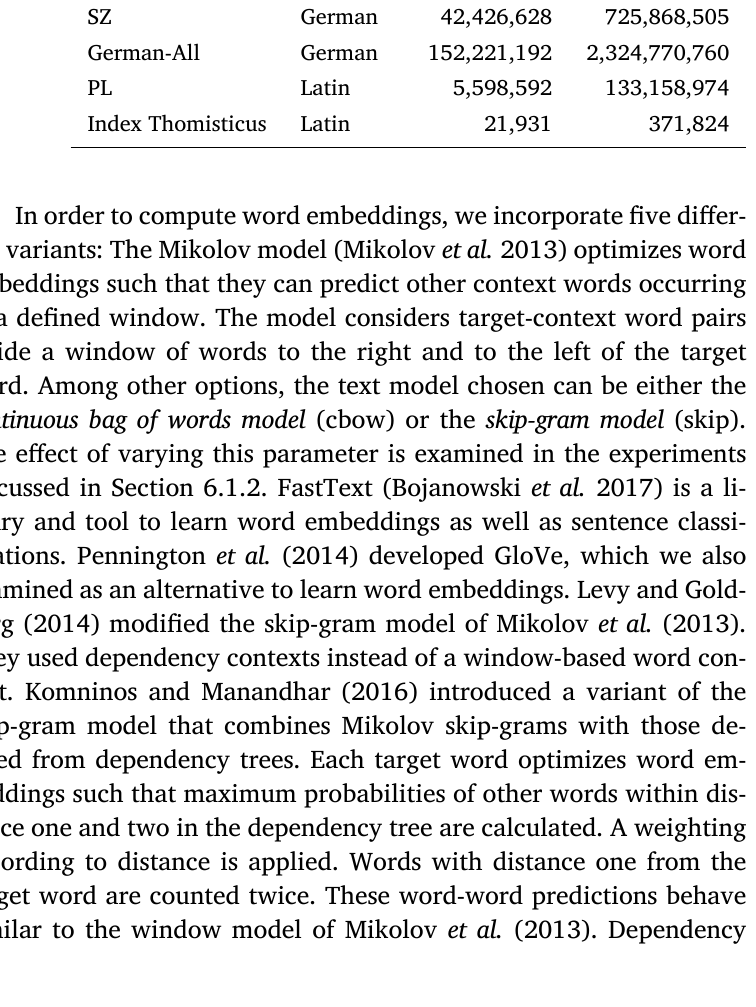
Statistics of supplementary corpora used in the experiments